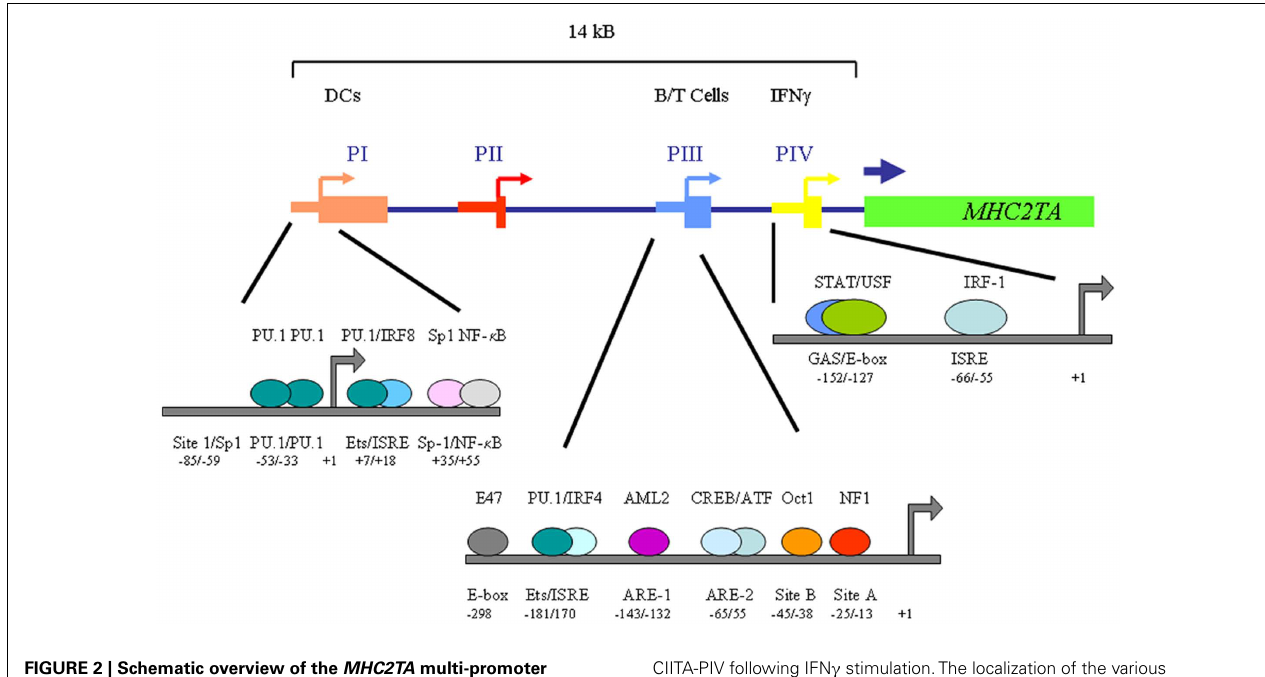
FIGURE 2 | Schematic overview of the MHC2TA multi-promoter region. Shown are the factors and elements governing transactivation of CIITA-PI in immature dendritic cells, CIITA-PIII in B cells and